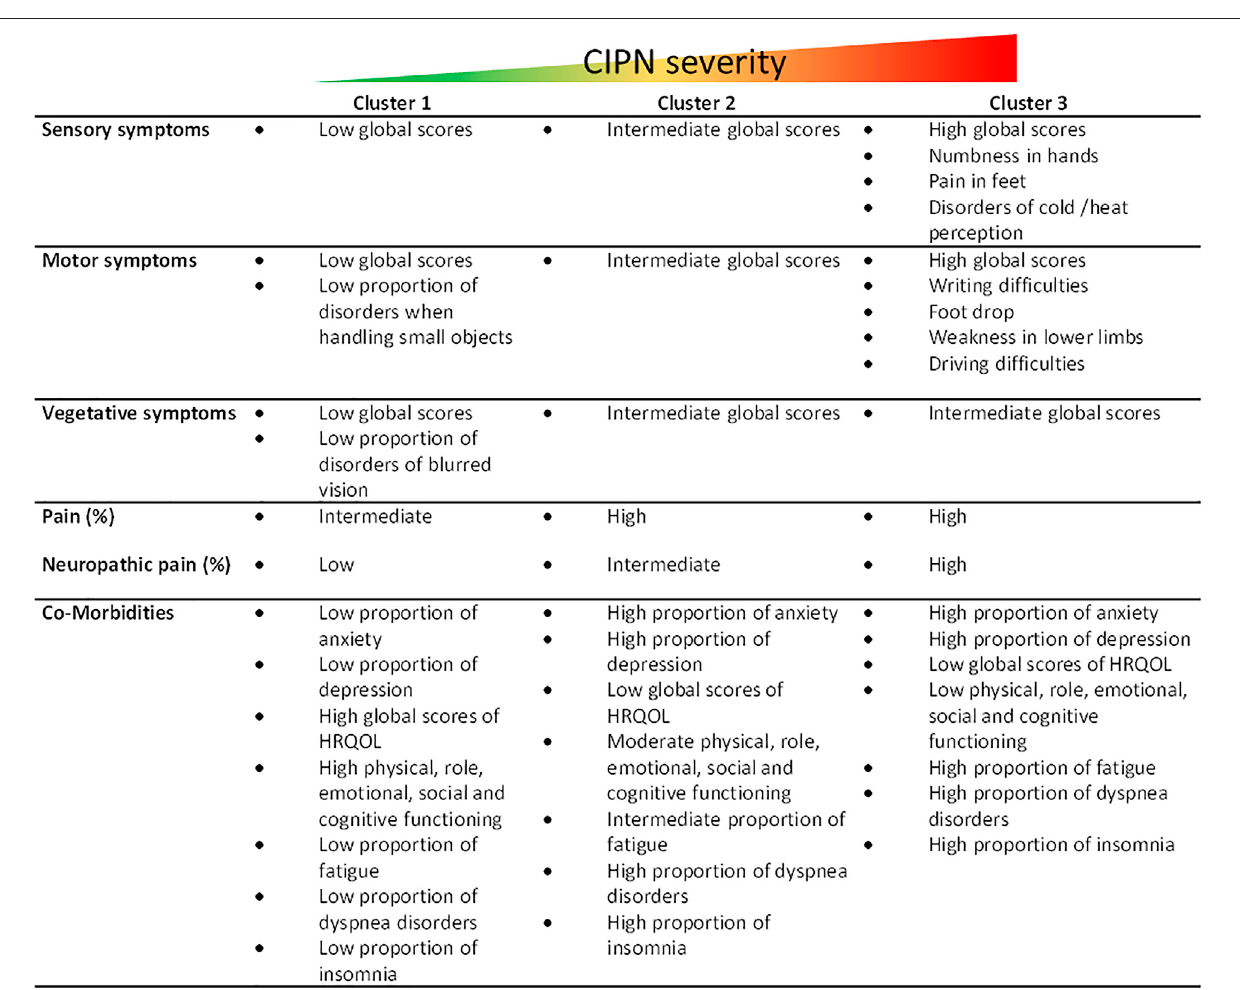
FIGURE 4 | Summary of cluster characteristics. Figure_supplementary fi le: Multiple correspondence analysis (MCA) plot of variables (A) and patients (B) . QLQ- CIPN20 – 17 (3 + 4): QLQ-CIPN20 questionnaire blurred vision, score “ quite a bit ” and “ very much ” HADS depression [8; 10]: HADS questionnaire, depression scale, suggestive scores between 8 and 10.QLQ-C30 - AP ≥ 66.7: QLQ-C30 questionnaire appetite loss, scores higher than or equal to 66.7. QLQ-C30 - AP [33.3; 66.7 [: QLQ-C30 questionnaire appetite loss, scores between 33.3 and 66.7 (66.7 excluded). QLQ-C30 - EF < 33.3: QLQ-C30 questionnaire emotional functioning, scoreslowerthan33.3.QLQ-C30-CF < 33.3:QLQ-C30questionnairecognitivefunctioning,scoreslowerthan33.3.QLQ-C30-CF[33.3;66.7[:QLQ-C30questionnaire cognitive functioning, scores between 33.3 and 66.7 (66.7 excluded). QLQ-C30-FA < 33.3: QLQ-C30 questionnaire fatigue, scores lower than 33.3. QLQ-C30-PA ≥ 66.7: QLQ-C30 questionnaire pain, scores higher than or equal to 66.7. QLQ-C30-RF < 33.3: QLQ-C30 questionnaire role functioning, scores lower than 33.3. QLQ- C30-RF [33.3; 66.7 [: QLQ-C30 questionnaire role functioning, scores between 33.3 and 66.7 (66.7 excluded) QLQ-C30-QOL < 33.3: C30 questionnaire global health status,scoreslower than 33.3QLQ-C30-SF < 33.3: QLQ-C30 questionnairesocialfunctioning, scoreslowerthan 33.3. QLQ-C30 - SL < 33.3: QLQ-C30 questionnaire insomnia, scores lower than